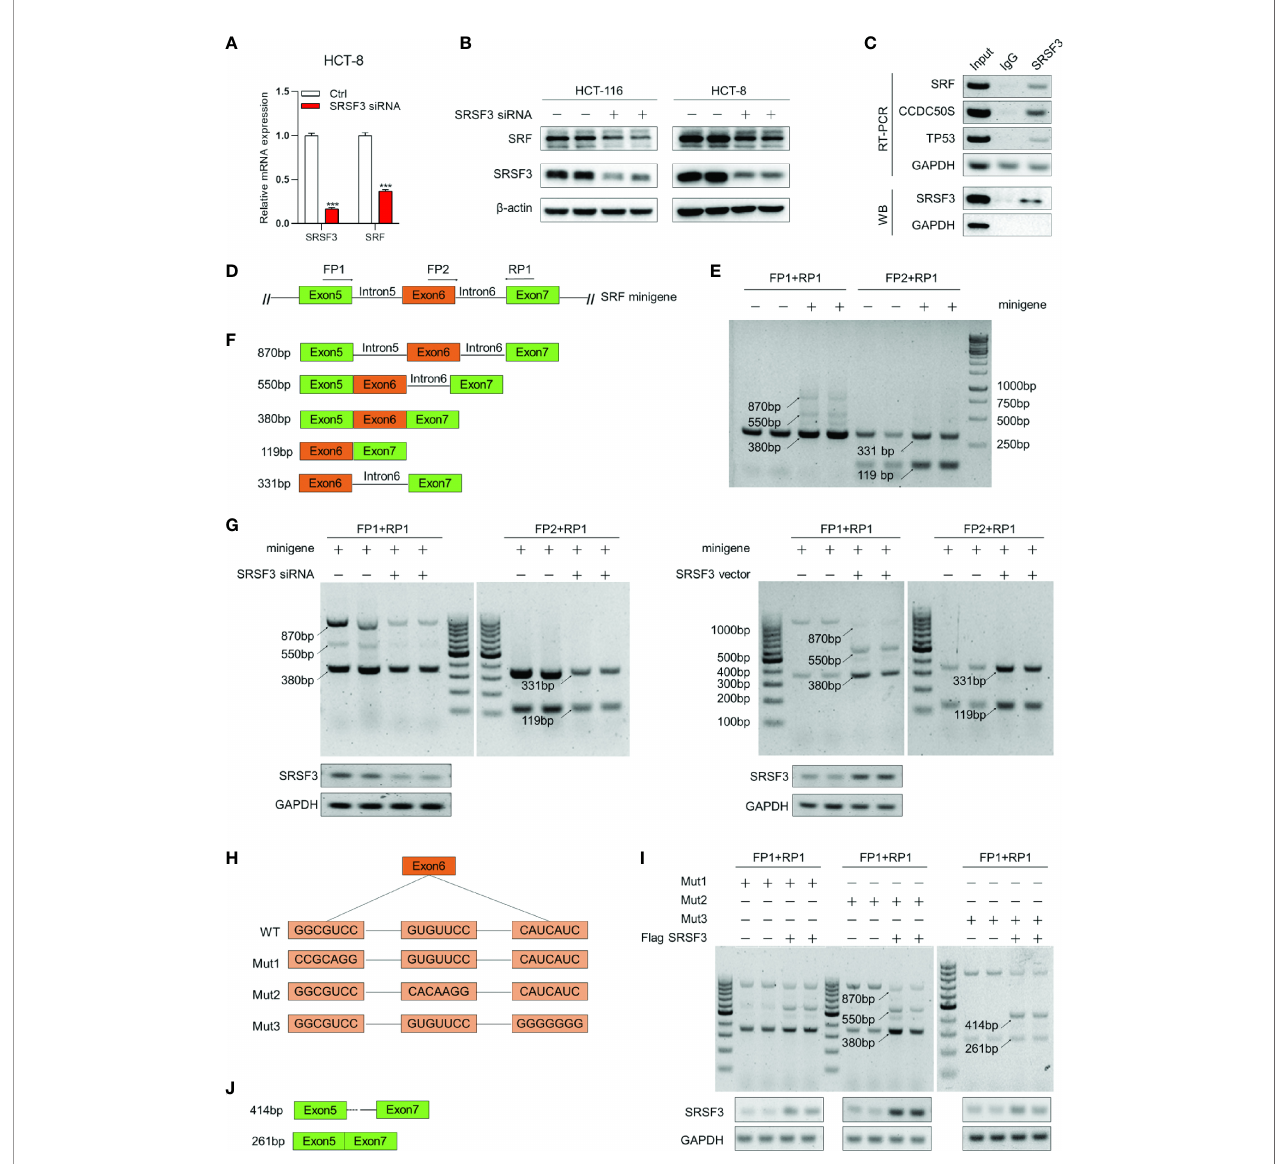
FIGURE 2 | SRSF3-regulated splicing of SRF . (A) qPCR assays for analyzing the effects of SRSF3 knockdown on SRF mRNA expression in HCT-8 cells ( n =6). (B) Western blotting to analyze the effects of SRSF3 knockdown on SRF protein expression in HCT-116 and HCT-8 cells ( n =2). (C) RIP assays for analyzing the binding of SRSF3 protein with SRF pre-mRNA in HCT-116 cells. GAPDH was used as a negative control, while TP53 and CCDC50S were used as positive controls (upper panels: RT – PCR for SRF mRNA, lower panels: immunoblotting for SRSF3 protein). (D) The schematic diagram of SRF mRNA and minigene. The SRF mRNA contains seven exons, and the predicted binding sites of SRSF3 were enriched on exons 5 to 7. The exons 5 – 7 were constructed into pcDNA3.1 vectors. Two forward primers (FP1 and FP2) and one reverse primer (RP1) were designed to amplify the transcripts of minigenes. (E) RT – PCR assays for investigating the transcripts of the SRF minigene in HCT-116 cells ( n =2). (F) Schematic diagram and sizes of SRF minigene transcripts analyzed by DNA sequencing. (G) RT – PCR assays for investigating the effects of SRSF3 knockdown or overexpression on SRF minigene transcripts in HCT-116 cells ( n =2). (H) Schematic diagram of three SRF minigene mutant plasmids. (I) RT – PCR assays for investigating the effects of SRSF3 overexpression on transcripts of SRF minigene mutant plasmids in HCT-116 cells ( n =2). (J) Schematic diagram and sizes of SRF Mut3 plasmid transcripts analyzed by DNA sequencing. Data represent mean±SD. Signi fi cance was assessed by two-sided t test . ***P